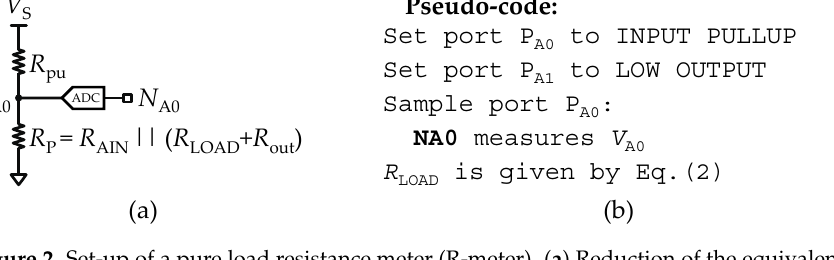
Figure 2. Set-up of a pure load resistance meter (R-meter). ( a ) Reduction of the equivalent circuit to a voltage divider circuit. ( b ) Pseudo-code used to implement the resistance meter mode.